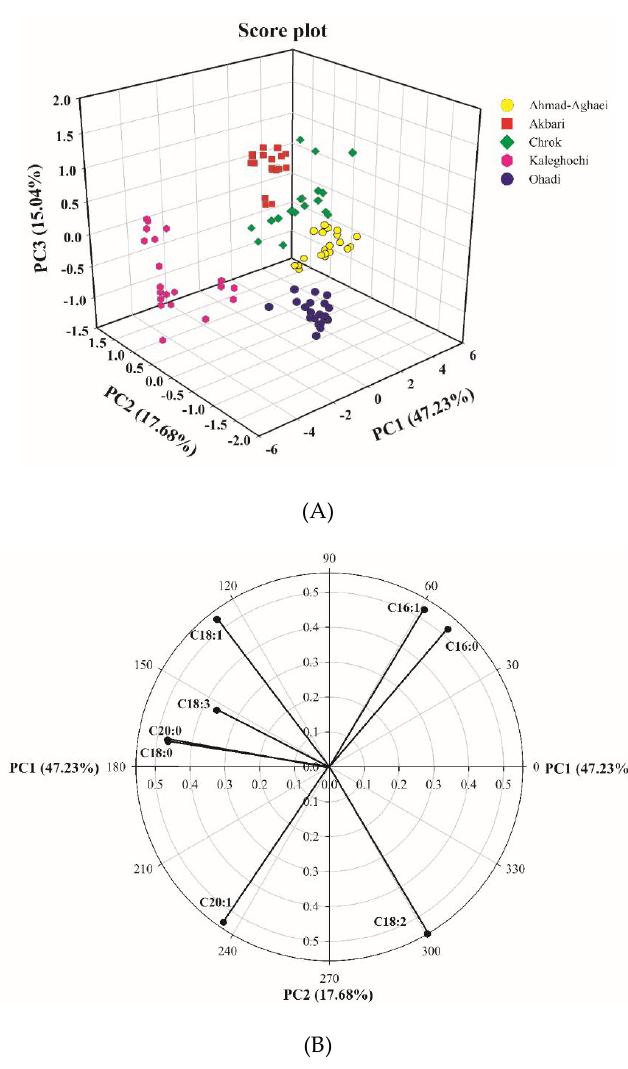
Figure 2. PC1–PC2–PC3 score plot from the matrix of the gas chromatographic peak areas of the fatty acid fingerprints from the pistachio samples ( A ), and PC1–PC2 loading plot from the matrix of the gas chromatographic peak areas’ fatty acid fingerprints from the pistachio samples ( B ).